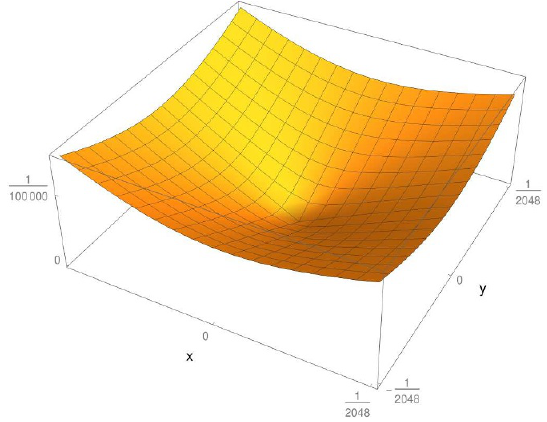
Figure 2 . The scalar potential generated by aligned flux, depending on the distance to the conifold C 1 in flat coordinates t 1 = x + Iy, t 2 = c c